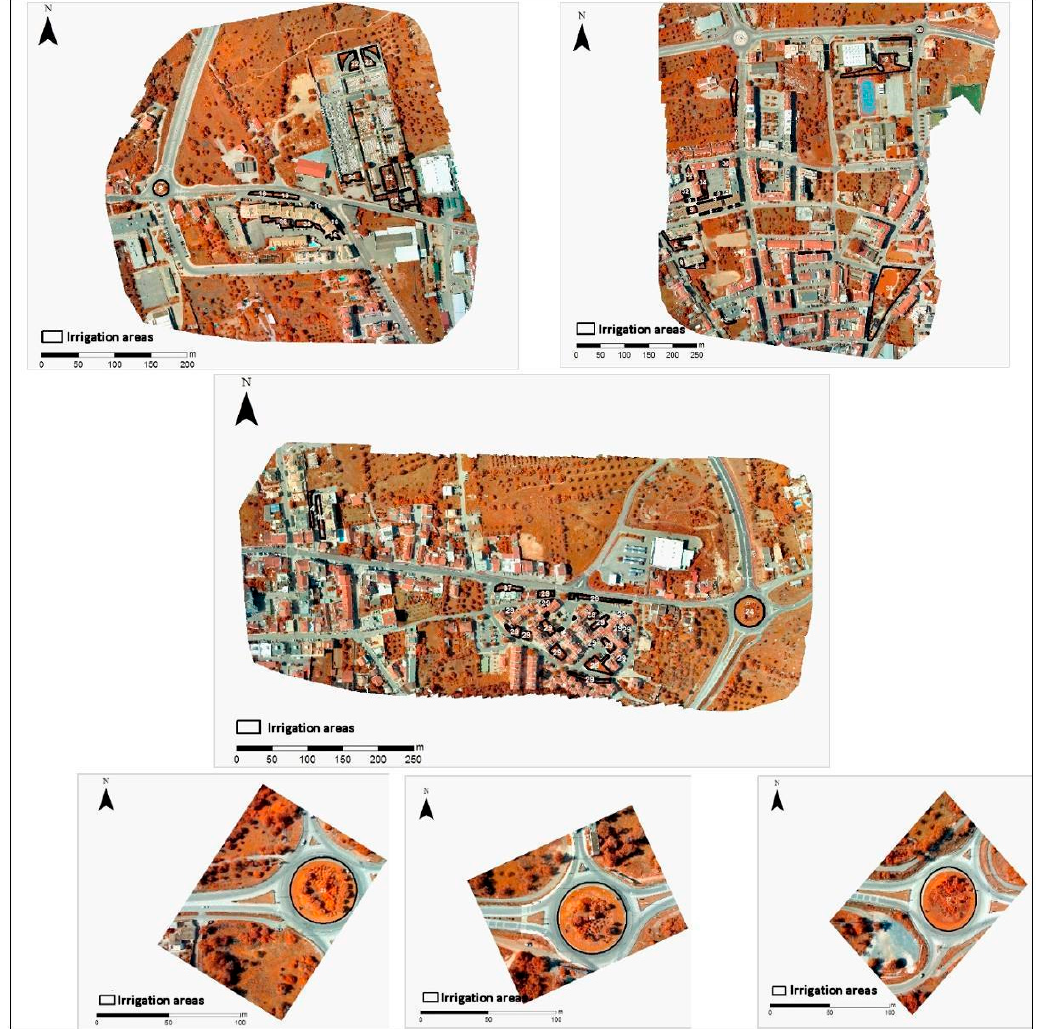
Figure 5. Near Infra-Red (NIR)-green-blue orthomosaics of six urban green areas from São Brás de Alportel.